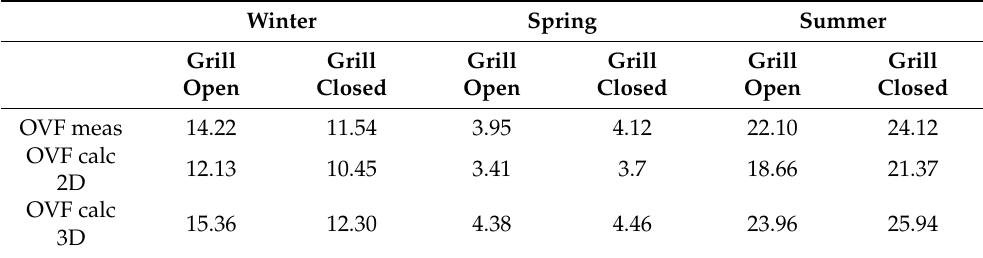
Table 11. Daily heat flux through the facades: measured and computed 2D and 3D